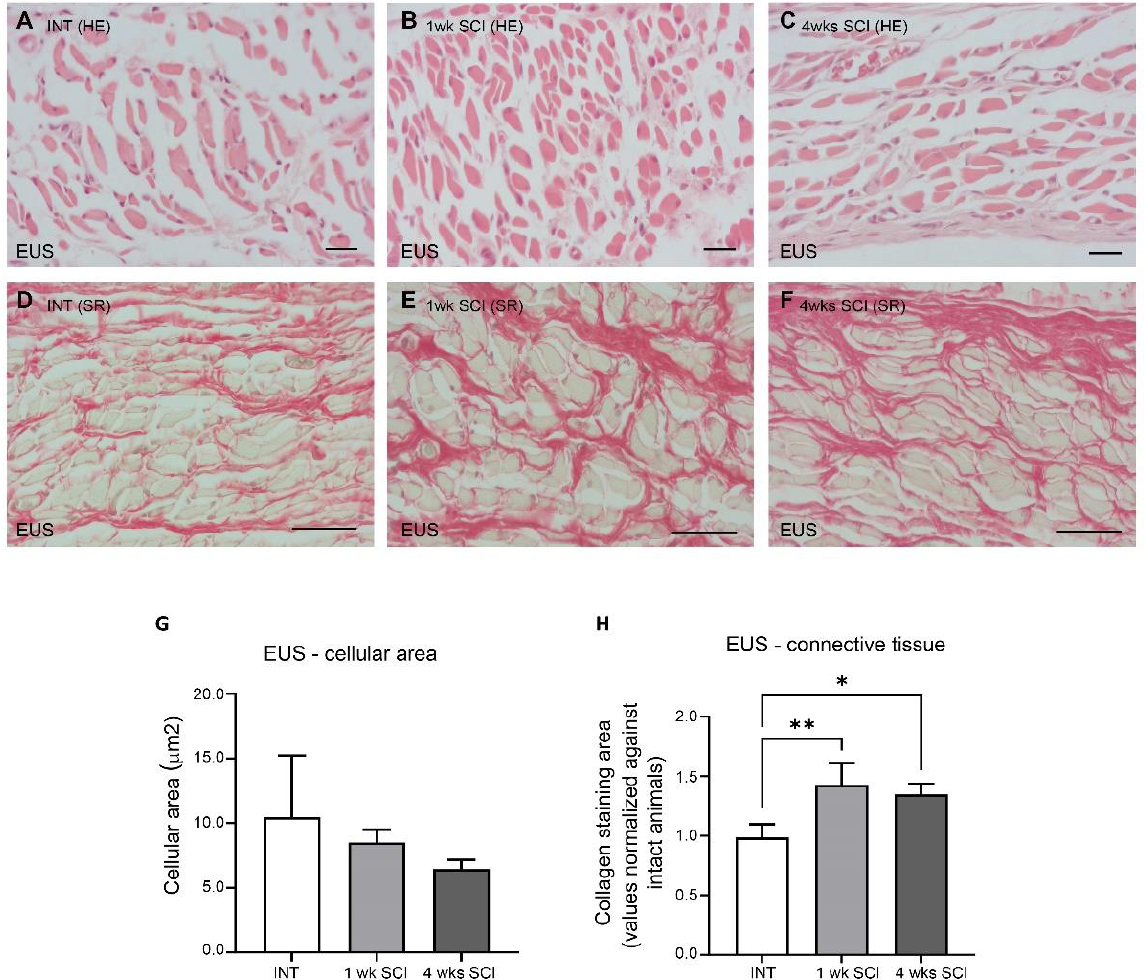
Figure 4. External urethral sphincter integrity. The morphology of the external urethral sphincter (EUS) striated cells was assessed by staining paraffin-embedded sections with haematoxylin–eosin. Spinal intact animals ( A ) presented long and slender striated cells, as well as 1-week ( B ) and 4-weeks SCI animals ( C ), with no changes in the cellular area ( G ). The levels of fibrosis, estimated by the collagen content stained with Sirius Red, significantly increased in SCI animals at 1 week post-SCI ( E ) and were still evident at 4 weeks after spinal lesion ( F ) when compared to controls ( D , H ) (* p < 0.05; ** p < 0.01). Scale bars equal 50 µ m. One-way ANOVA followed by a Tukey’s multiple comparison test.